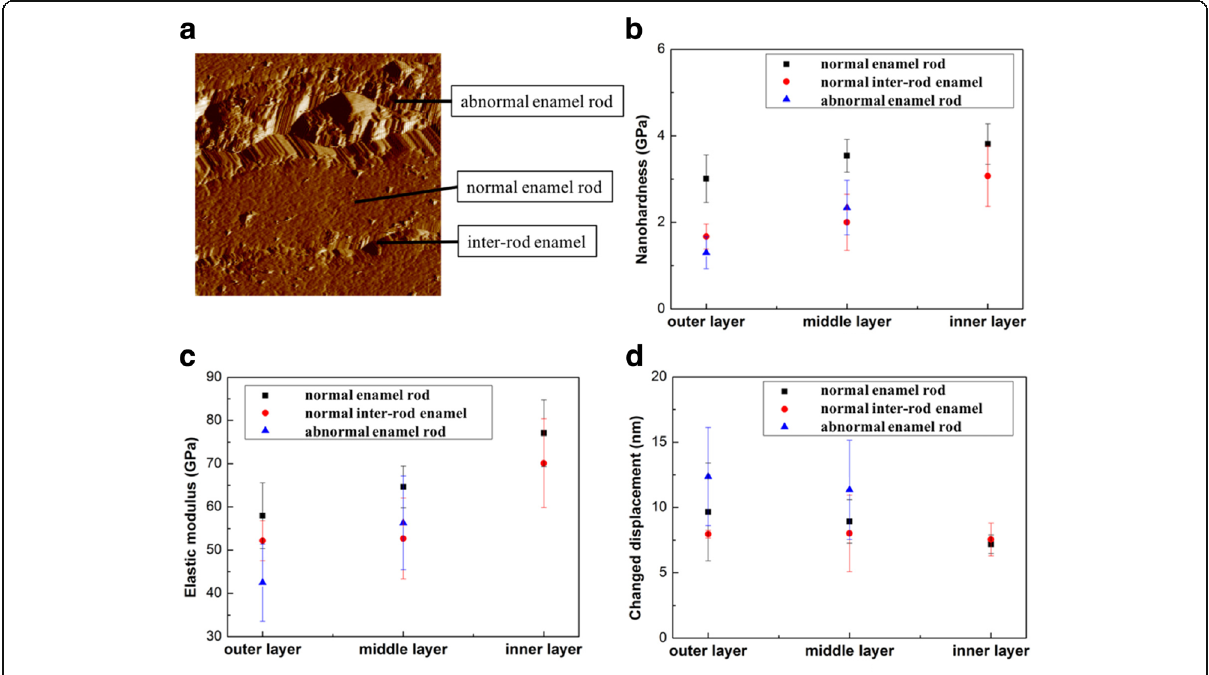
Fig. 8 Nanomechanical properties of the normal and abnormal enamel rods of severe dental fluorosis. a Normal enamel rod, abnormal enamel rod, and inter-rod enamel are labeled in SPM image of the outer enamel of severe dental fluorosis. b Nanohardness. c Elastic modulus. d Nanoindentation creep